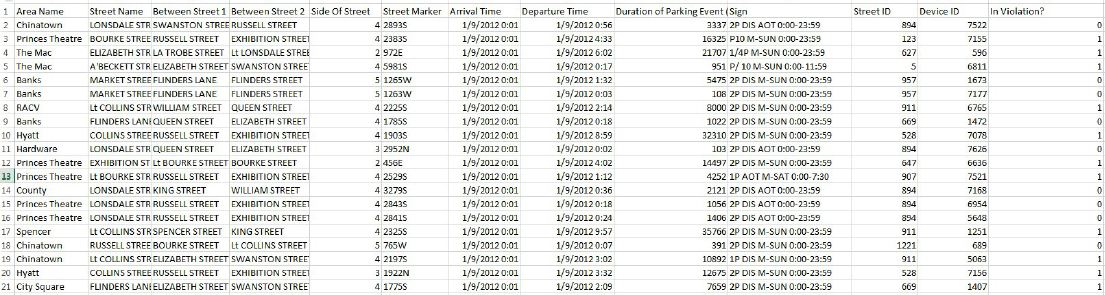
Figure 2. A sample of parking sensor data (source: Victoria State Government, City of Melbourne) and violation detection based on sensor